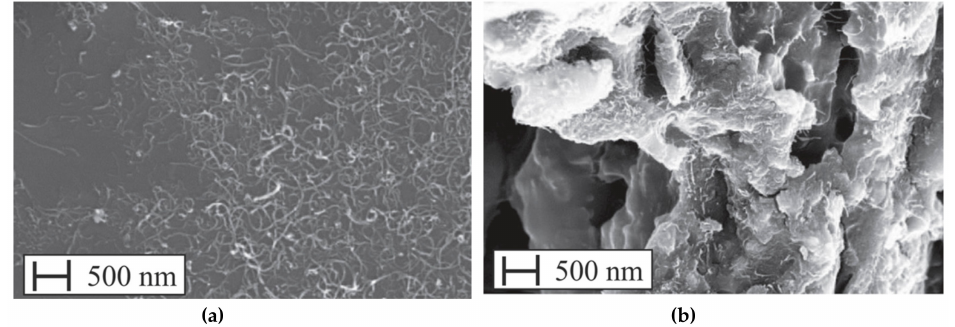
Figure 19. SEM images of the MWCNTs dispersion in ( a ) water suspensions after sonication and ( b ) in